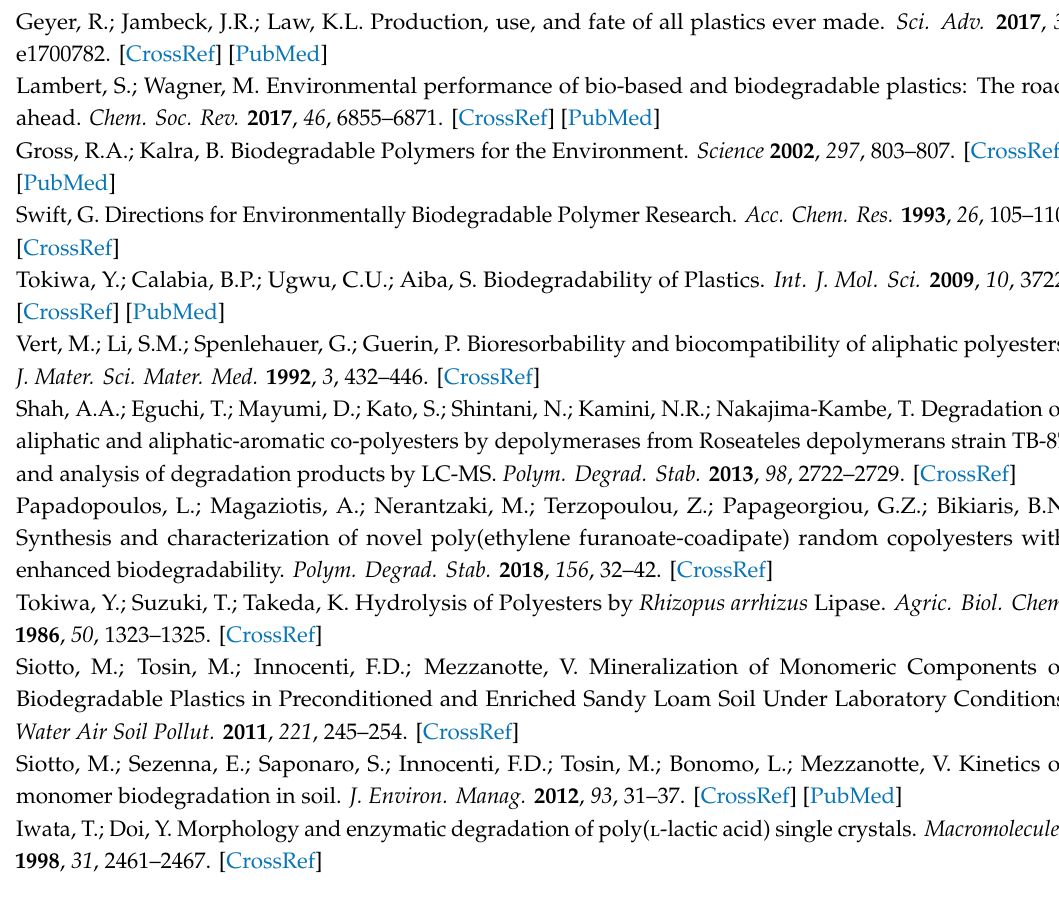
Figure S1: Overview of NMR spectra of the polymers 5% BP-C 2 , 10% BP-C 2 , 25% BP-C 2 , and 75% BP-C 2 , Figure S2: Overview of TGA results of the polymers after immersion in demineralized water for 1 day, Figure S3: Overview of GPC traces directly after synthesis and after 12 weeks immersion in demineralized water for the polymers 5% BP-C 2 , 10% BP-C 2 , 25% BP-C 2 , and 75% BP-C 2 , Figure S4: Overview of LC elugrams of the water phase where polymers 0% BP-C 2 , 50% BP-C 2 , 100% BP-C 2 were immersed in for 12 weeks, Figure S5: Example of the results of the peak fitting procedure described in the